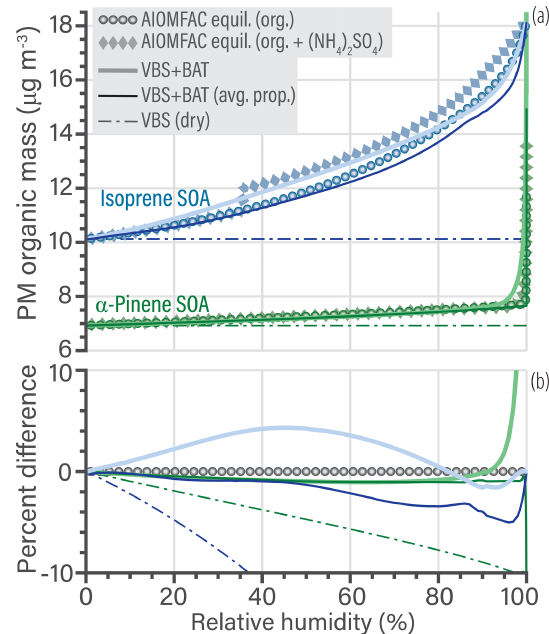
Figure 7. (a) Comparison of predicted PM organic mass concentra- tions as a function of equilibrium relative humidity for a bulk solu- tion ( = a w ) at 298.15K. Simulations for isoprene SOA are shown in blue and those for α -pinene SOA in green. The benchmark AIOM- FAC equilibrium predictions are shown for the salt-free cases (cir- cles); for comparison, an additional case (diamonds) shows SOA mixed with approximately 50% ammonium sulfate (dry mass frac- tion). In the AIOMFAC equilibrium calculation, ammonium sulfate crystallization was suppressed for RH > 35%. Note that the am- monium sulfate mass concentration in the PM is not shown, only its indirect effect on organic mass concentration. The thick curves show the VBS + BAT predictions with multiple organic surrogate components of individual molecular properties, while the thin curve shows a simulation assuming a hypothetical average molecule cal- culated from the dry mass, i.e., a mass-weighted mean of O : C j , H : C j , and M j , but keeping the set of individual molecule effec- tive C sat values to mimic a distribution of volatilities. The thin j, dry dashed line shows the standard VBS simulation ignoring water up- take (dry). (b) The percentage difference of the three VBS simu- lations compared to the organics-only benchmark case. Figure S8 of the Supplement shows an equivalent graph but with expanded